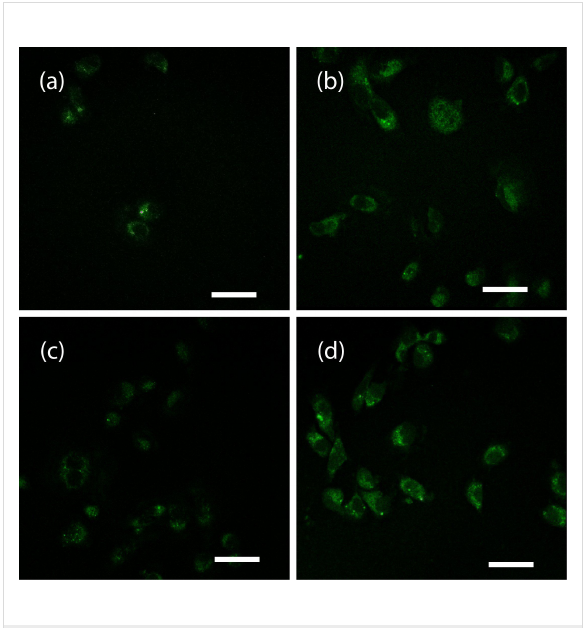
Figure 4: Confocal laser scanning micrographs of IGROV1 exposed to hydrogel 6 (a), to hydrogel 7 (b), to hydrogel 8 (c) and to hydrogel 9 (d). The dansyl group fluorescence is shown in green. Scale bar 50 μ